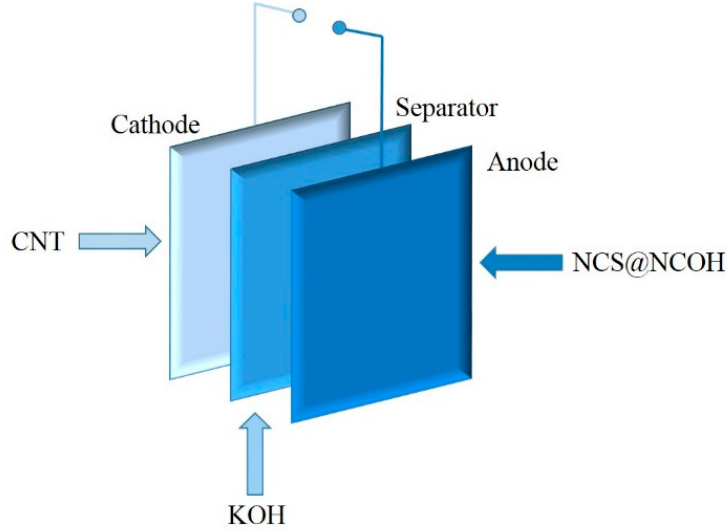
Figure 10. Schematic illustration of assembled asymmetric supercapacitors.